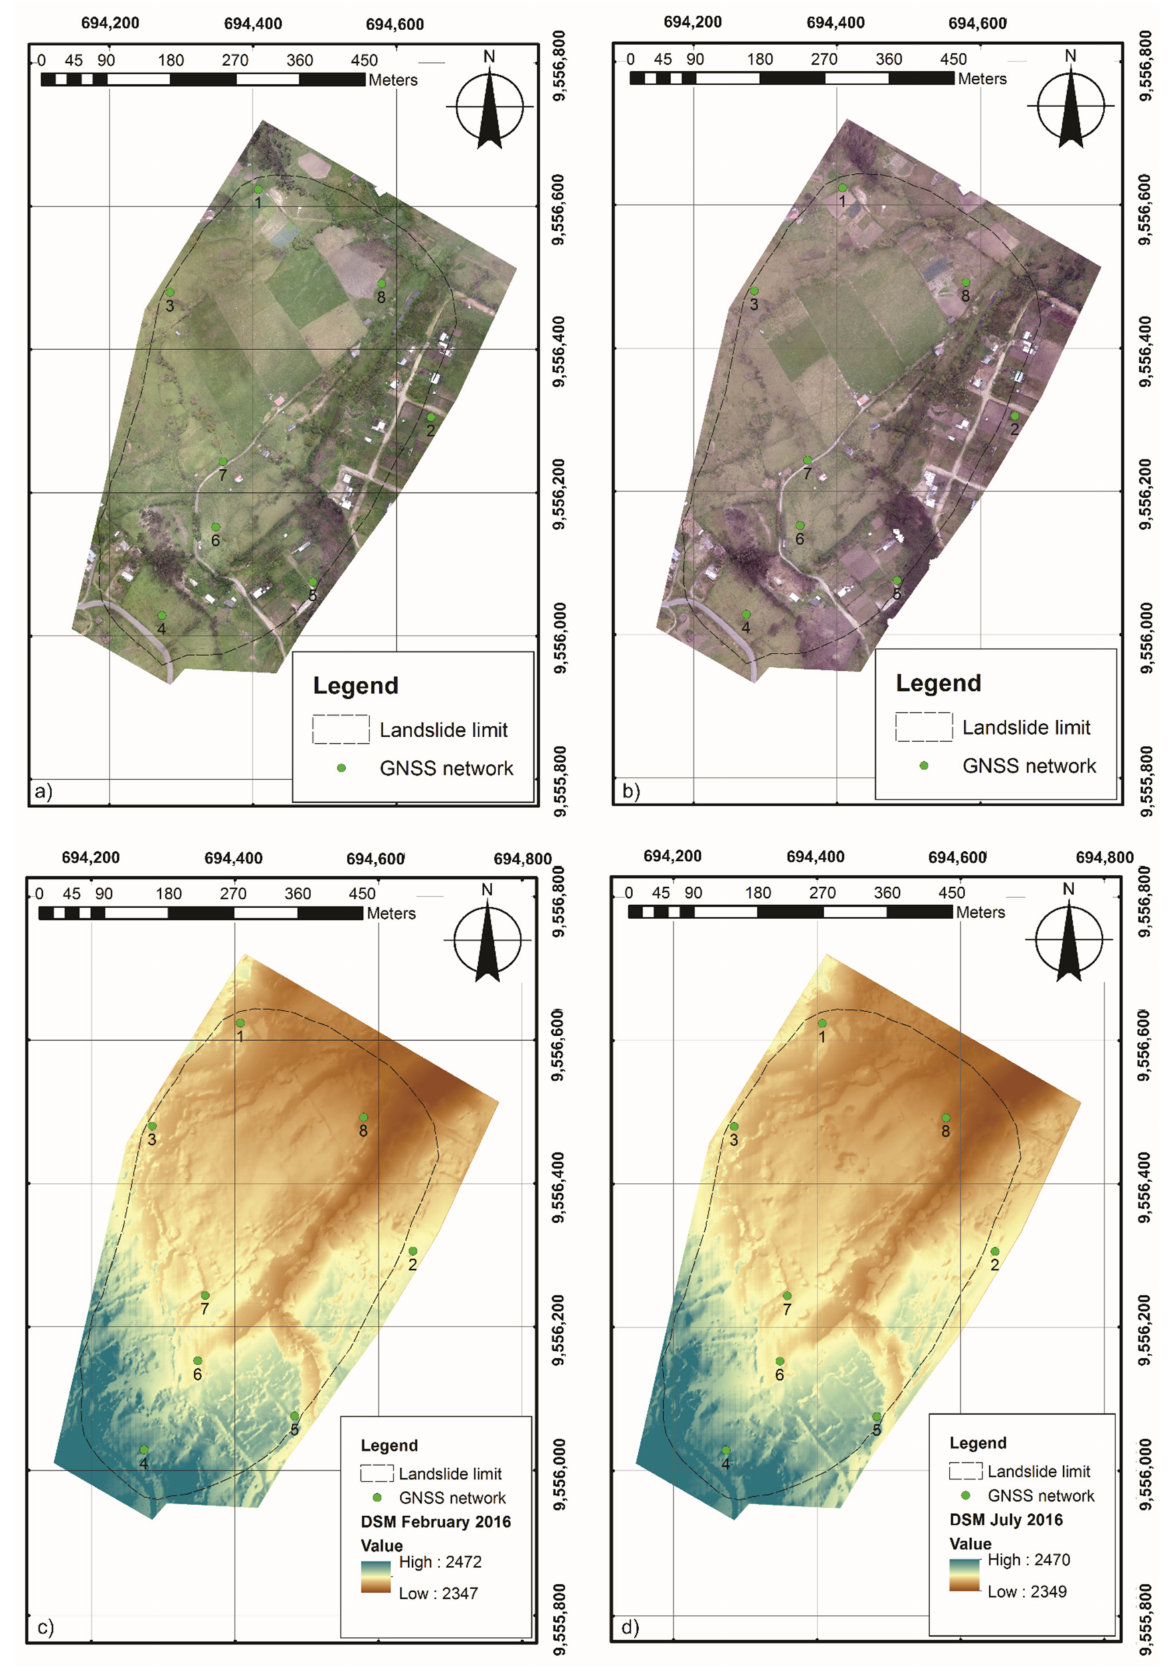
Figure 5. Orthophotos and DSMs of the Victoria study area generated by RPAS flights: ( a , c ) 18 February 2016; ( b , d ) 11 June